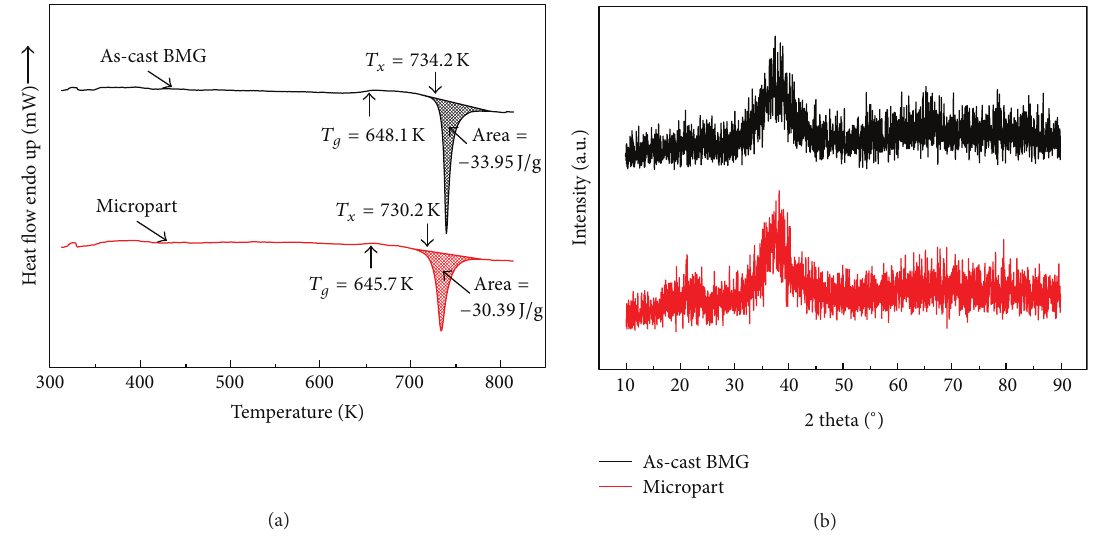
Figure 7: The results of DSC (a) and XRD (b) for the as-cast BMG and